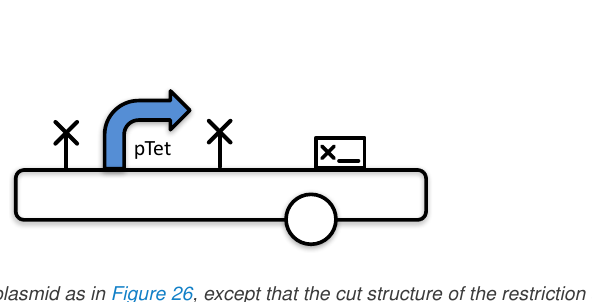
Figure 28: Promoter stored in a plasmid as in Figure 26, except that the cut structure of the restriction sites before and after the promoter is not specified.